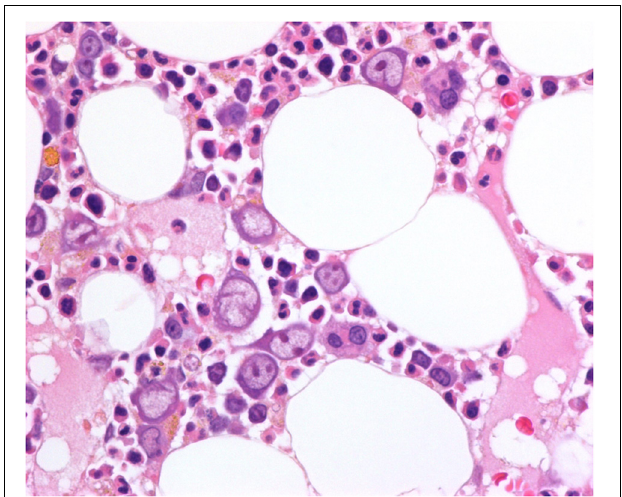
FIGURE 2 | Bone marrow biopsy at time of diagnosis, hematoxylin and eosin (H&E) stain, original magnification 600 × . Giant proerythroblasts are present, and some of them contain prominent eosinophilic nuclear inclusion bodies. Other stages of erythroid maturation are markedly reduced.